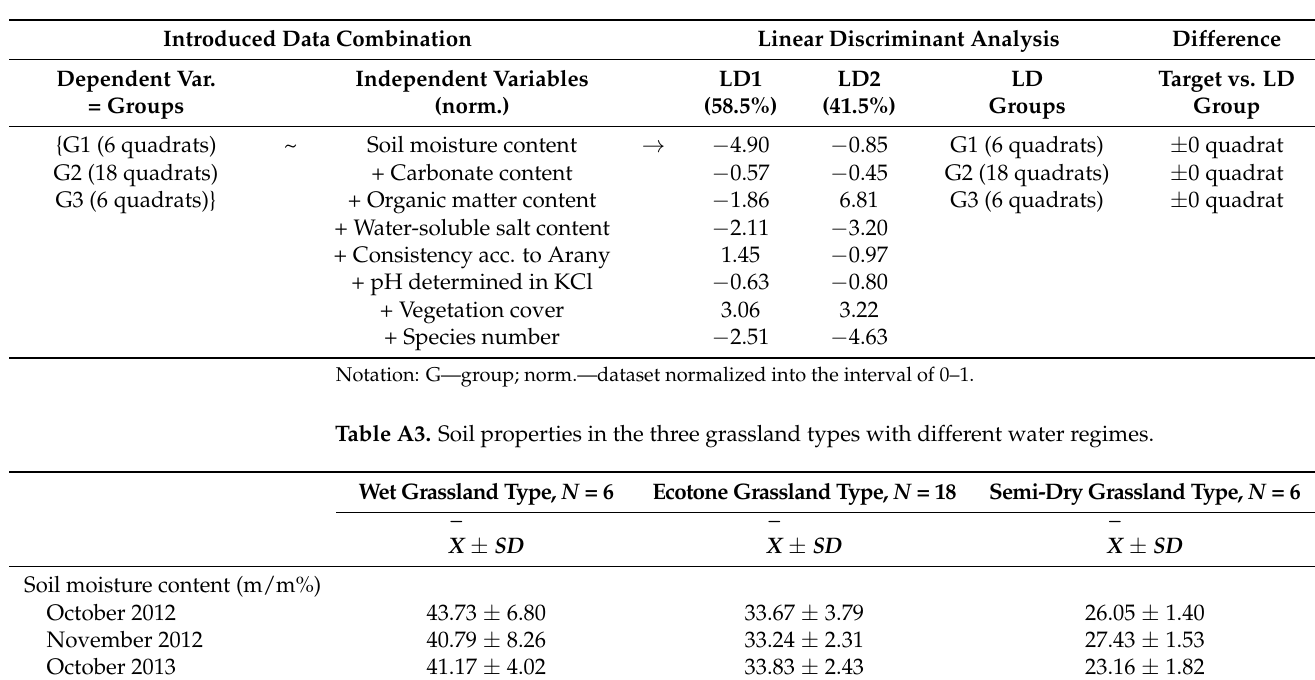
Table A2. Separability of the three predefined groups of quadrats along the slope, based on local soil and above-ground vegetation properties (linear discriminant analysis). Soil properties refer to the 0–10 cm soil depth interval.